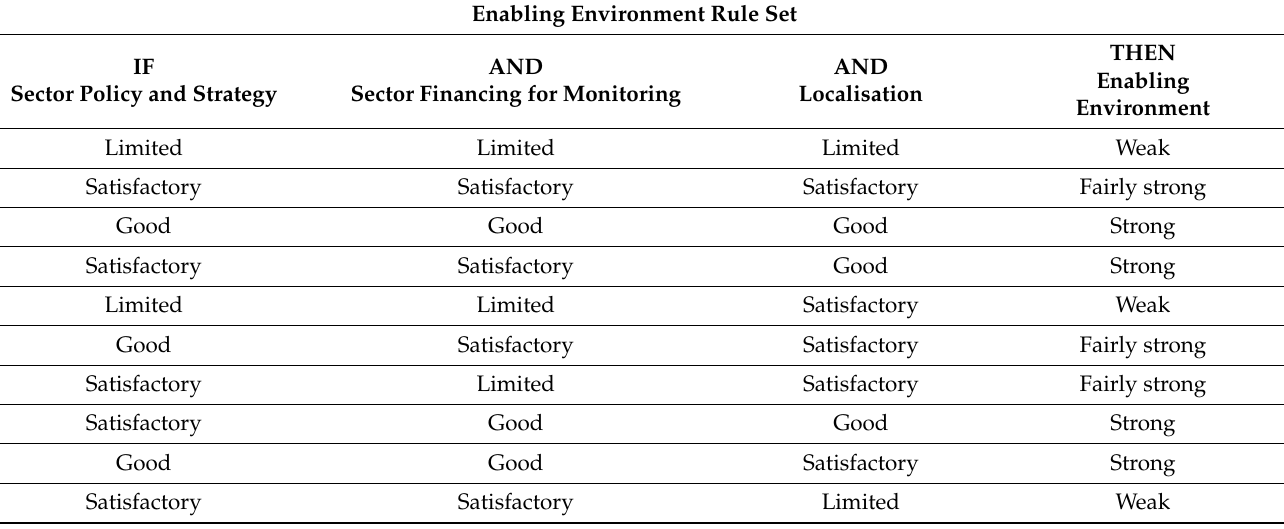
Table 2. Rule set for enabling environment factor for fuzzy modelling.